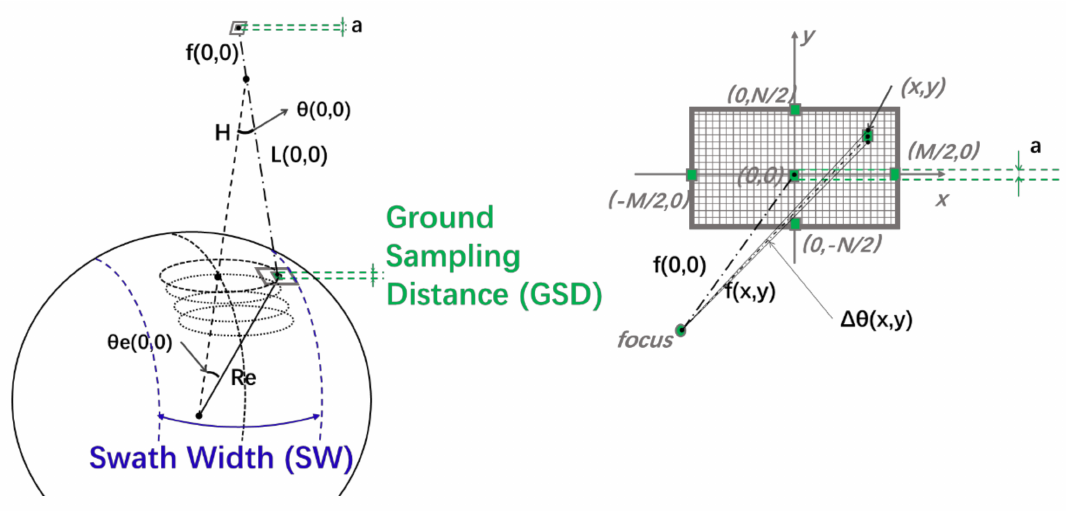
Figure 2. A diagram of the Swath Width (SW) and Ground Sampling Distance (GSD).